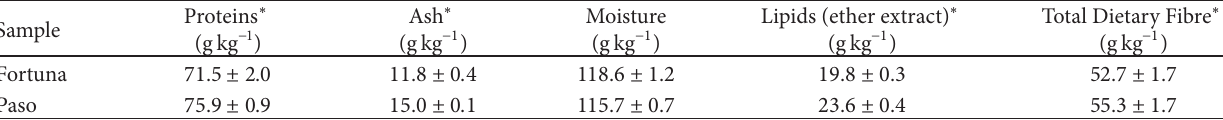
Table 1: Composition of raw rice ∗∗ .